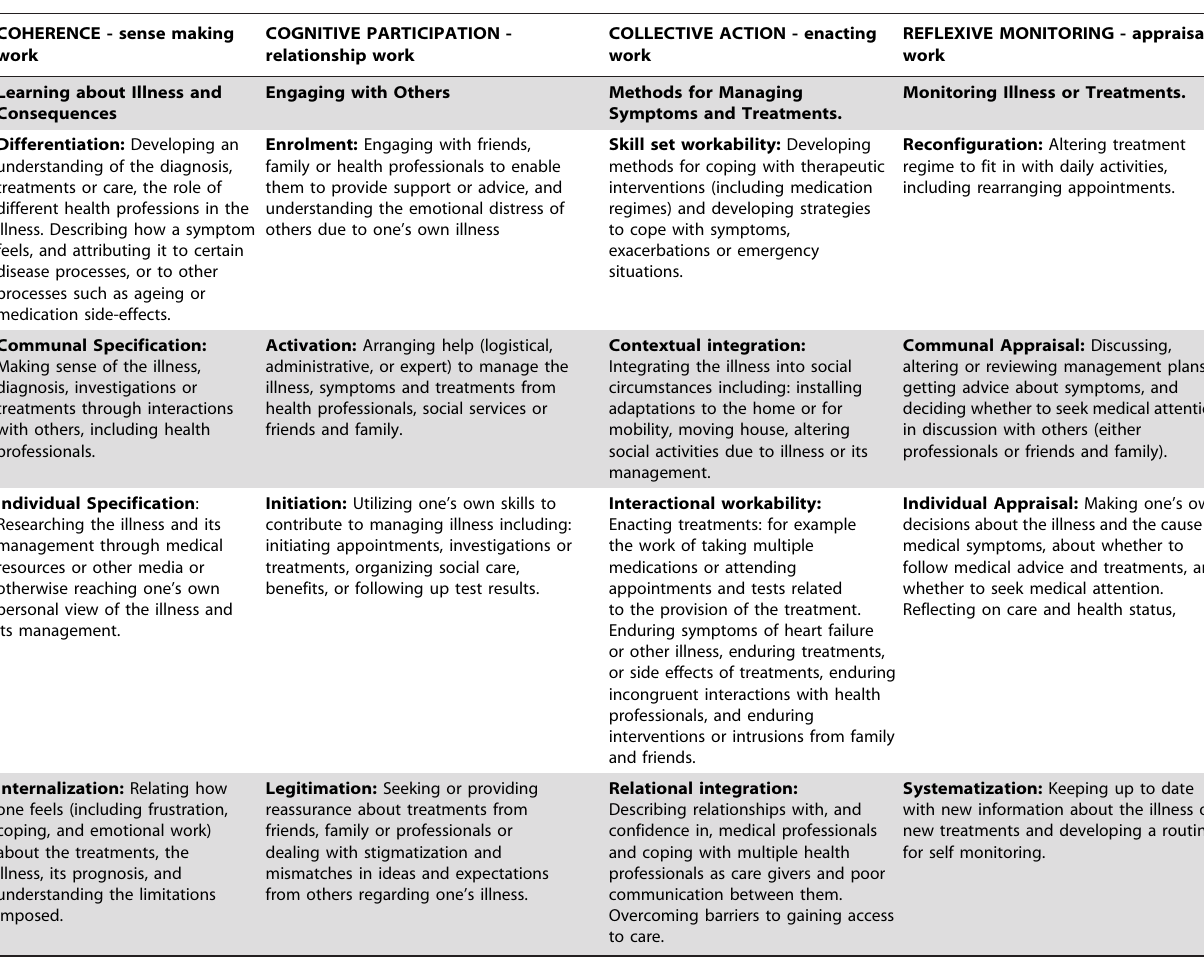
Table 1. Normalisation Process Theory Coding Frame for Advanced Heart